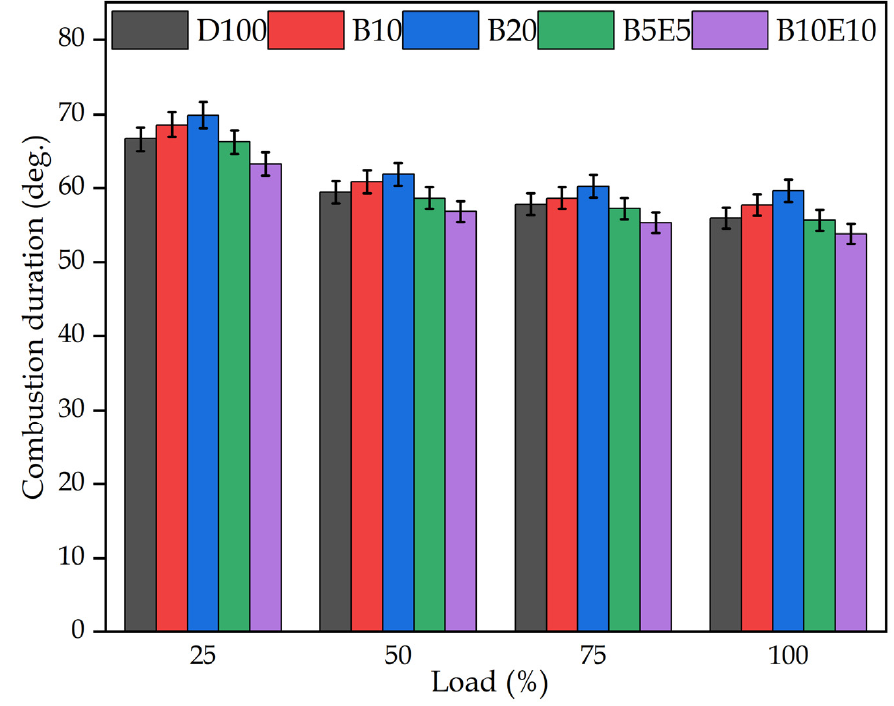
Figure 7. Combustion duration of various fuel blends against engine load.